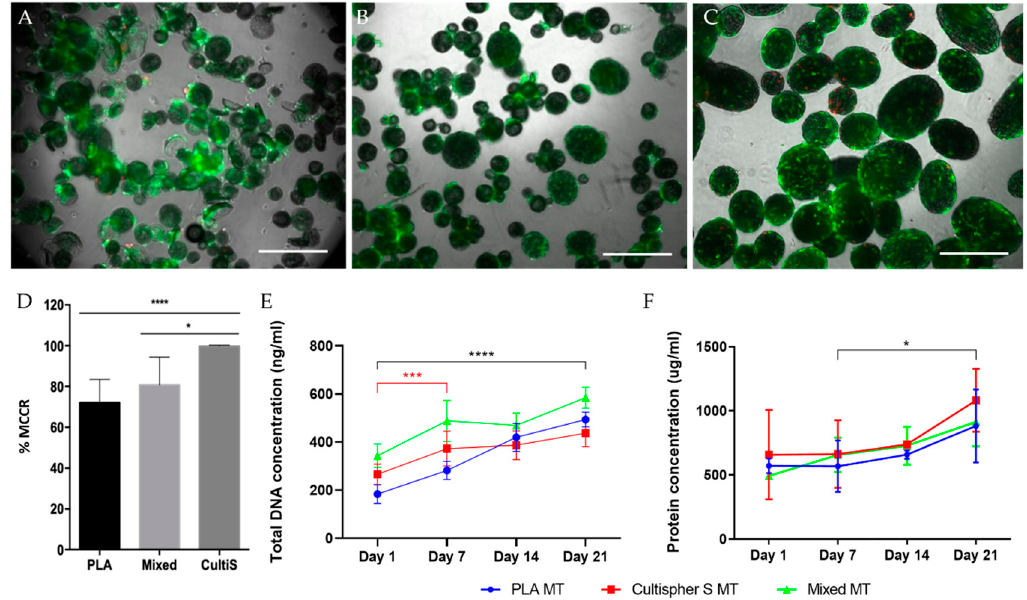
Figure 4. PLA, Cultispher ® S and mixed MT development. ( A ) Live-dead staining of cell-seeded PLA MCs, scale bar = 500 µ m. ( B ) Live-dead staining of cell-seeded mixed MCs, scale bar = 500 µ m. ( C ) Live-dead staining of cell-seeded Cultispher ® S MCs, scale bar = 500 µ m. Alive cells (green), dead cells (red). ( D ) Percentage of particle colonization (MCCR). ( E ) Cell proliferation over MT development. ( F ) Protein deposition over MT development. * p -value ≤ 0.05, *** p -value ≤ 0.001, **** p -value ≤ 0.0001.